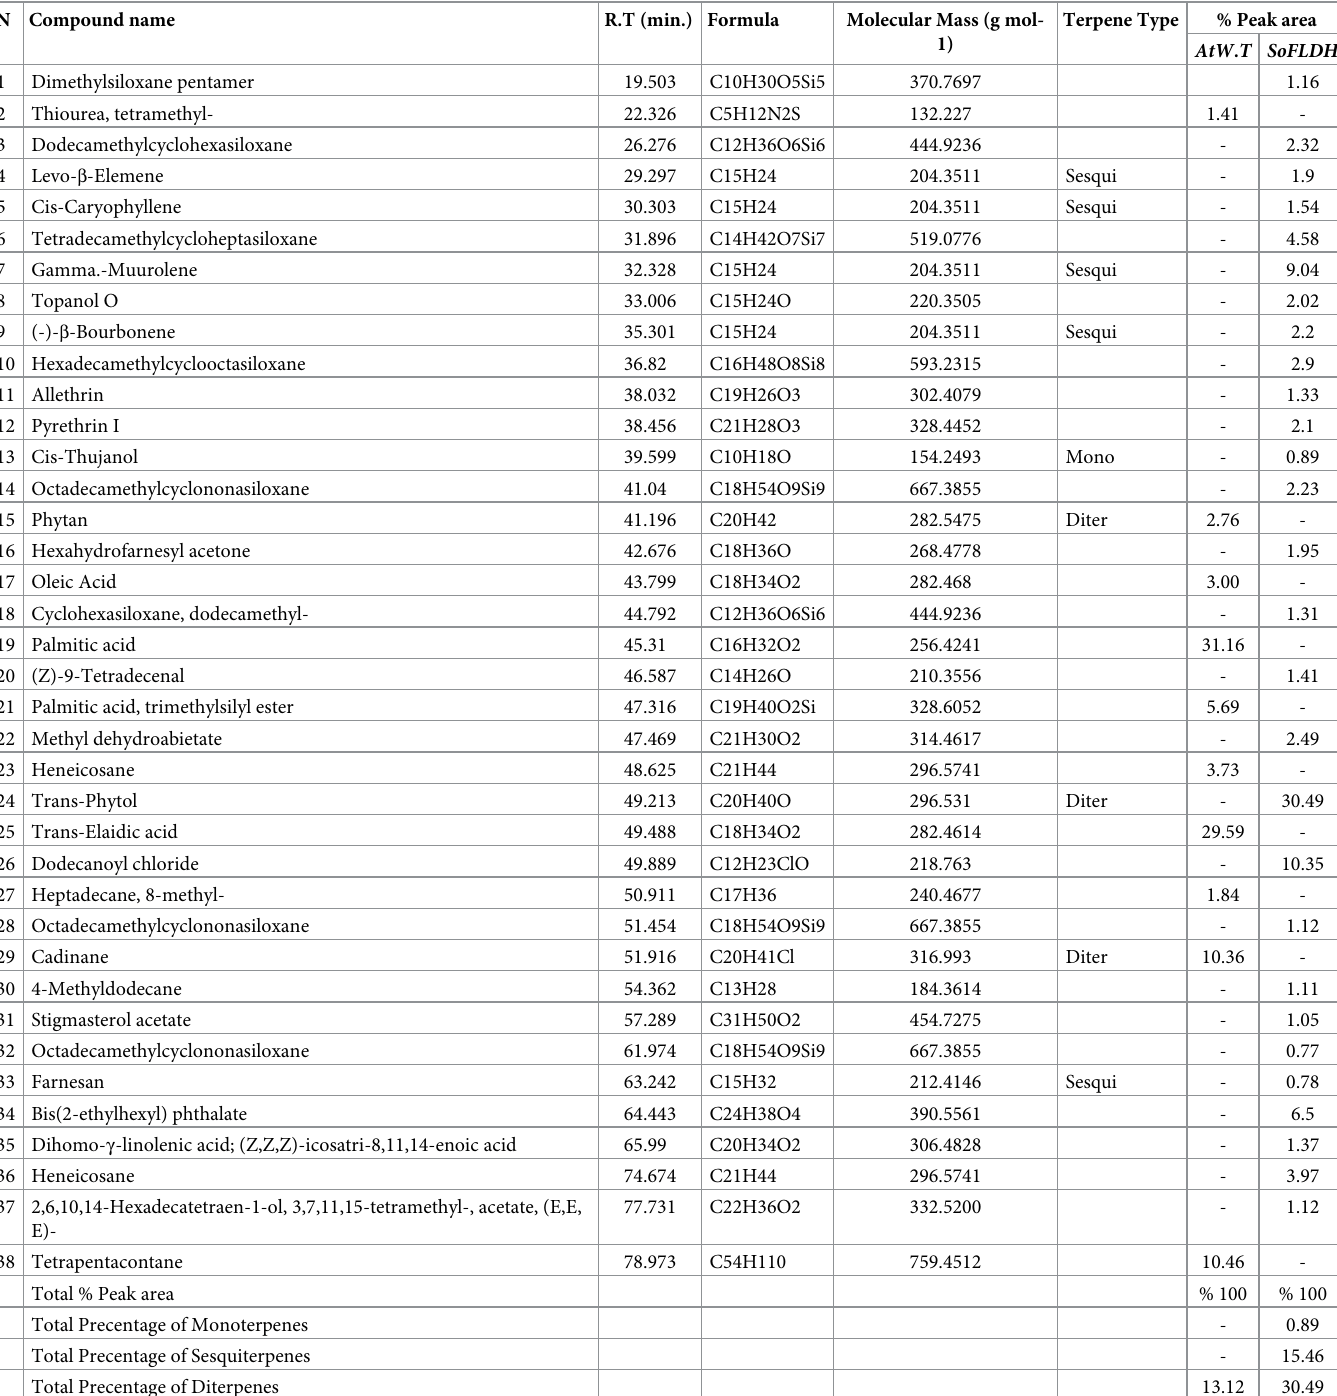
Table 1. The major Terpenoid compositions in transgenic A . thaliana leave over-expressing of SoFLDH